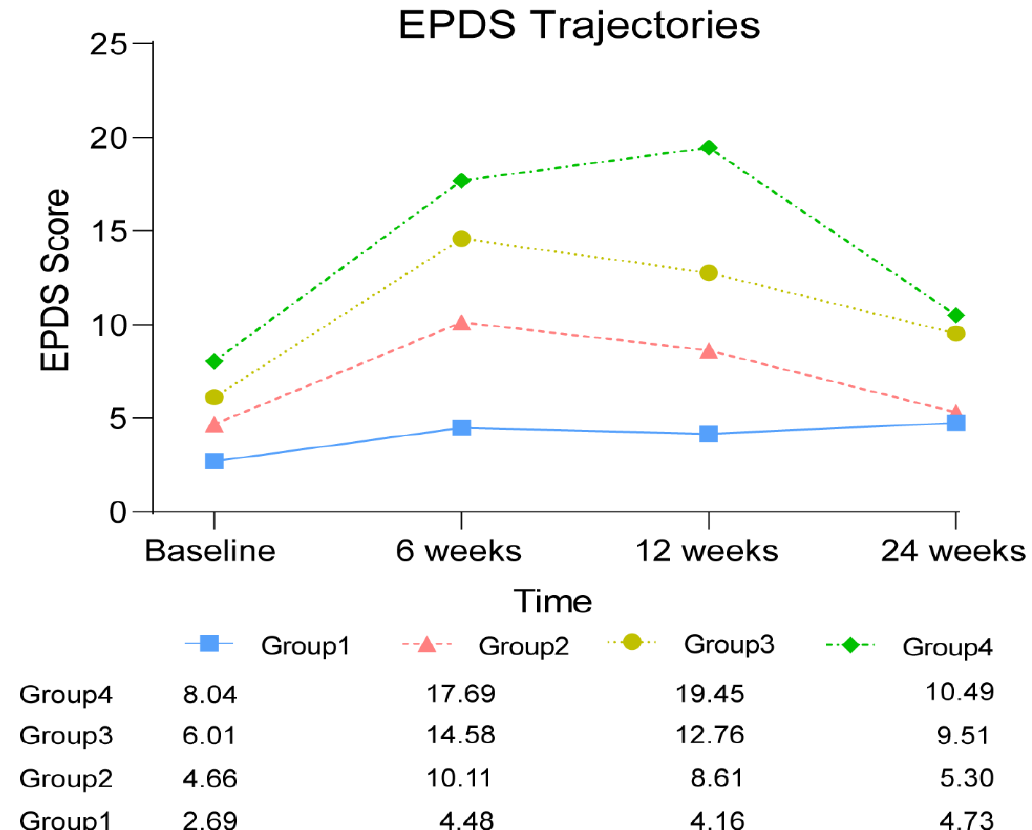
Figure 2. EPDS trajectory.